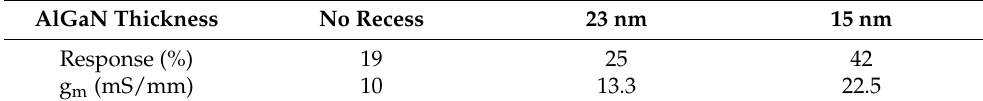
Figure 5. The dependence of ( a ) response with V GS = 0 V and ( b ) transconductance on AlGaN barrier thickness. Gas condi- tion: 4%-H 2 in argon background gas, 200 °C. Table 1. Maximum response and transconductance dependence on AlGaN barrier thickness.